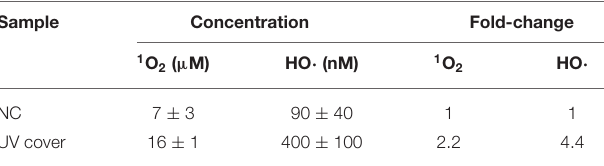
TABLE 1 | Reactive oxygen species (ROS) analysis using electron spin resonance (ESR) after treatment in UV cover mode. Sample Concentration